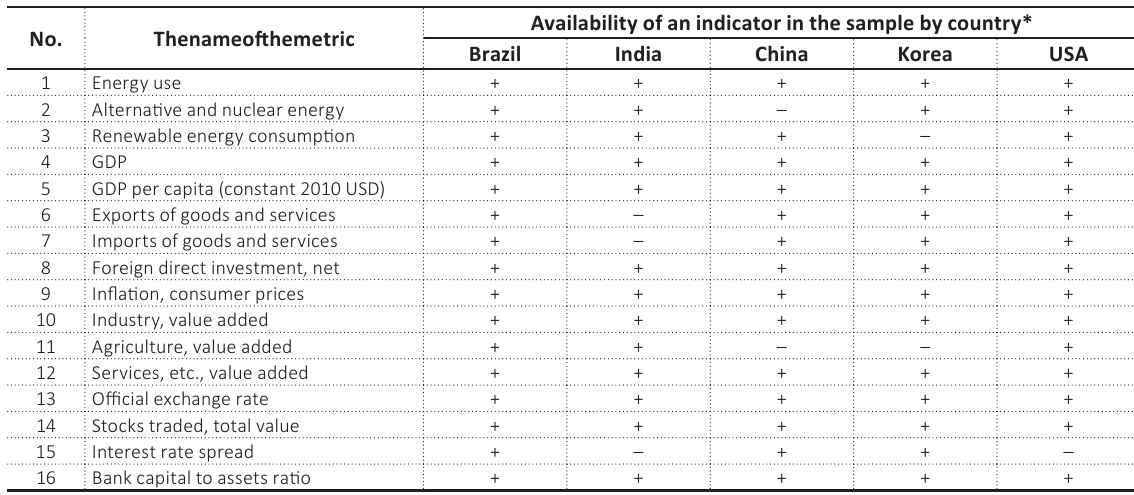
Source: World Bank, World Data